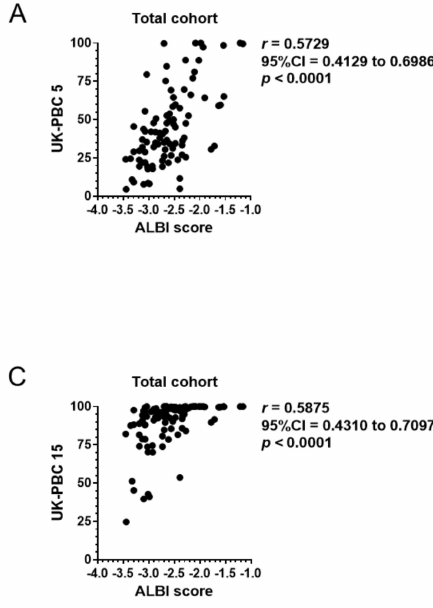
Figure 4. Correlation of the baseline ALBI score with UK-PBC score. ( A – C ) In 93 patients with available blood exam data one year after UDCA therapy, the ALBI score at the beginning of UDCA prescription significantly correlated with UK-PBC risk scores 5, 10 and 15. ALBI, albumin–bilirubin; CI, confidence interval; T-Bil, total bilirubin; Alb, albumin; Plt, platelet count; UDCA, ursodeoxycholic acid.